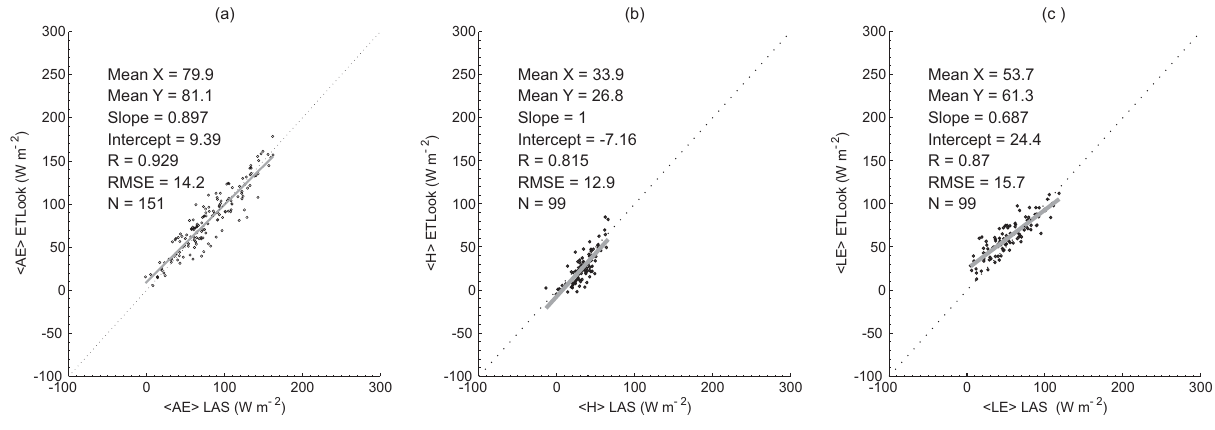
ETLook and the estimated fluxes from LAS-data correlate rather well and are close to the expected 1 : 1 relation. From this comparison it can also be seen that LAS estimates the daily average of < H > on average slightly higher than ET- Look, and as both estimates of < LE > are based on the en- ergy balance equation, it is clear that the LAS-derived daily < LE > -fluxes are on average slightly lower than estimated by ETLook. However, the RMSE-values for daily H and LE of respectively 12.9 and 15.7 W m − 2 and R -values of 0.815 and 0.87 are also comparable to the results of Teixeira et al. (2009) where RMSE values of 41.8 and 33.8 W m − 2 were found with R 2 -values of 0.93 and 0.83 between SEBAL es- timates and field measurements of H and LE.